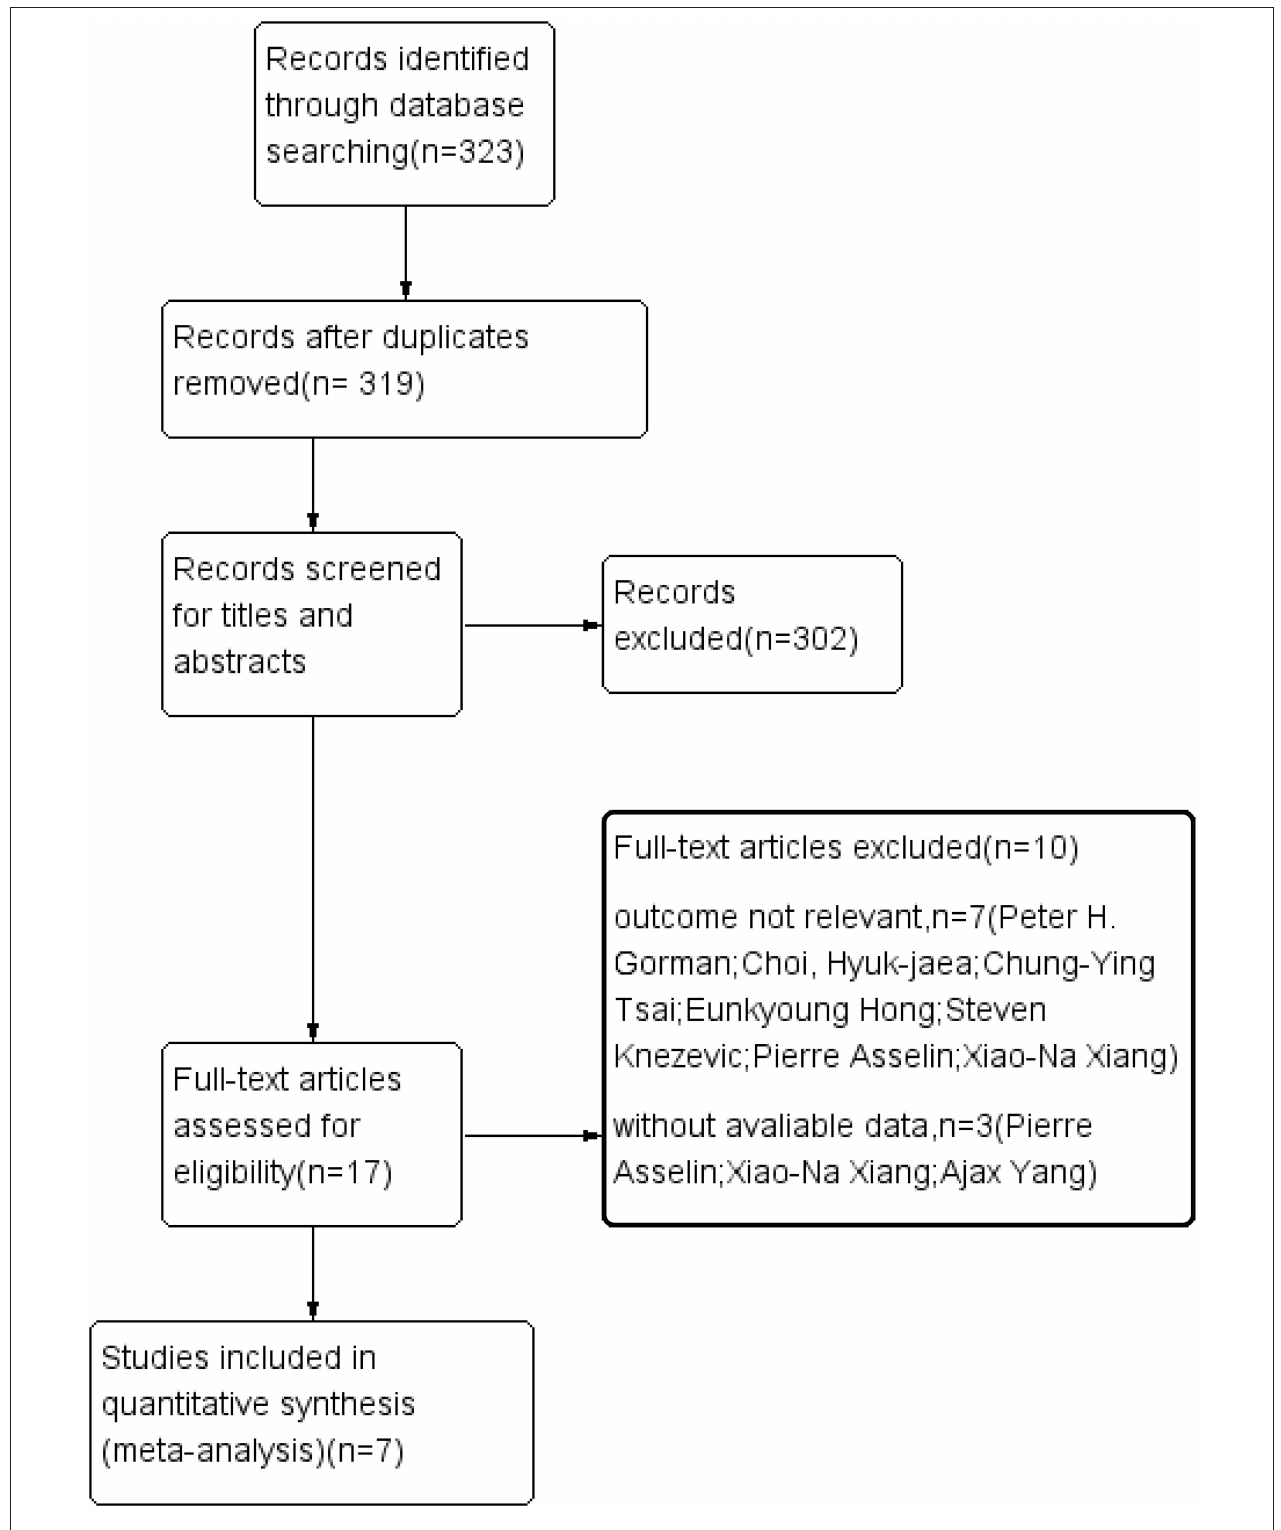
FIGURE 1 | Flow diagram of the literature selection